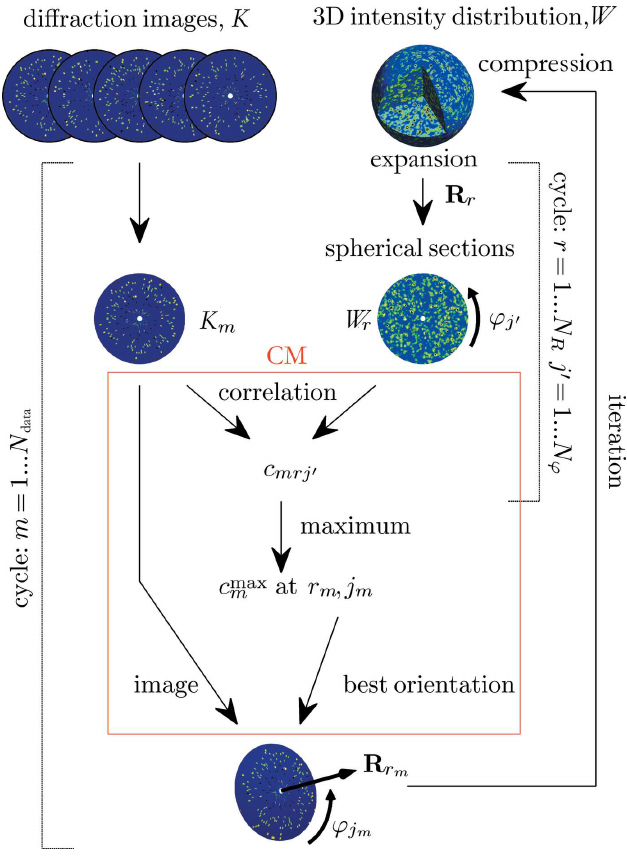
Figure 2 A flowchart of the CM method. The CM step (replacing the expectation- maximization step of the EMC method) is inside the red